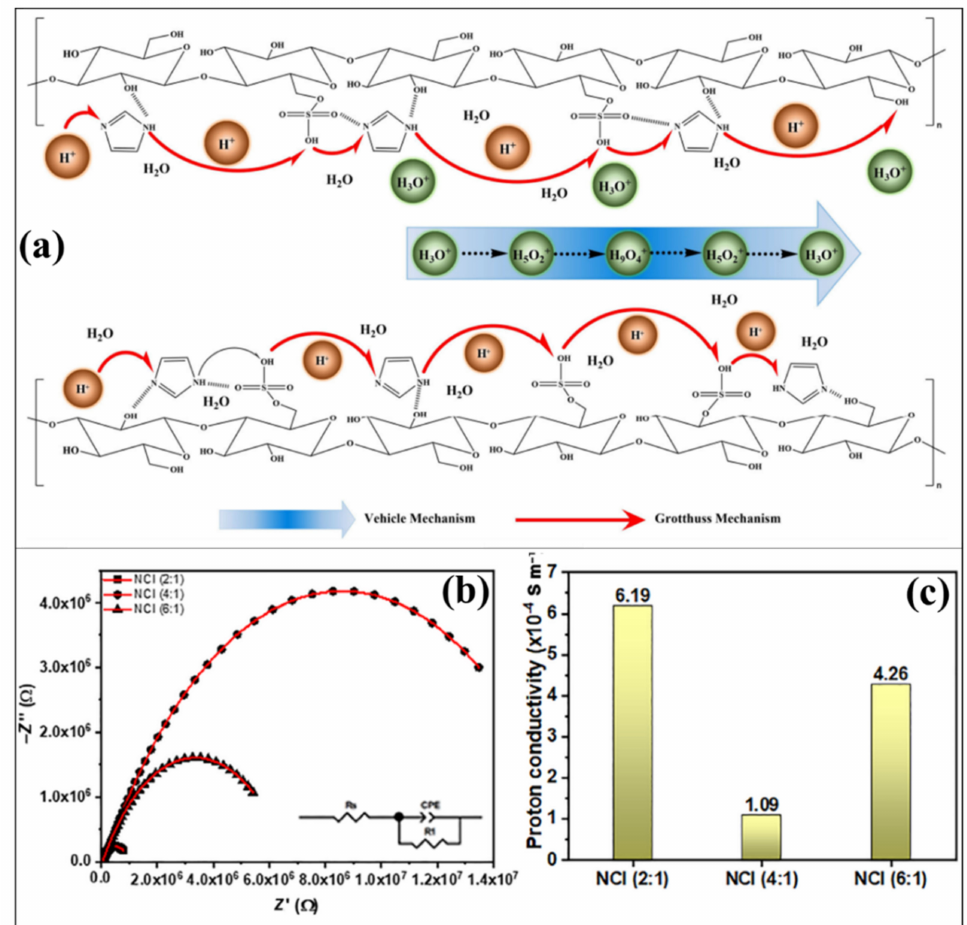
Figure 5. ( a ) Possible proton transport mechanism in sulfonated CNC − Imidazole membrane. ( b ) Nyquist plot and ( c ) proton conductivity of Nafion − CNC − imidazole membranes. Reprinted with permission from Ref. [115]. Copyright © 2021 Society of Chemical Industry (SCI). (License Number: